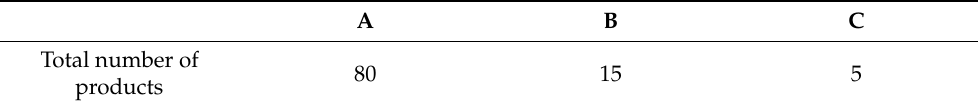
Table 1. ABC analyses.